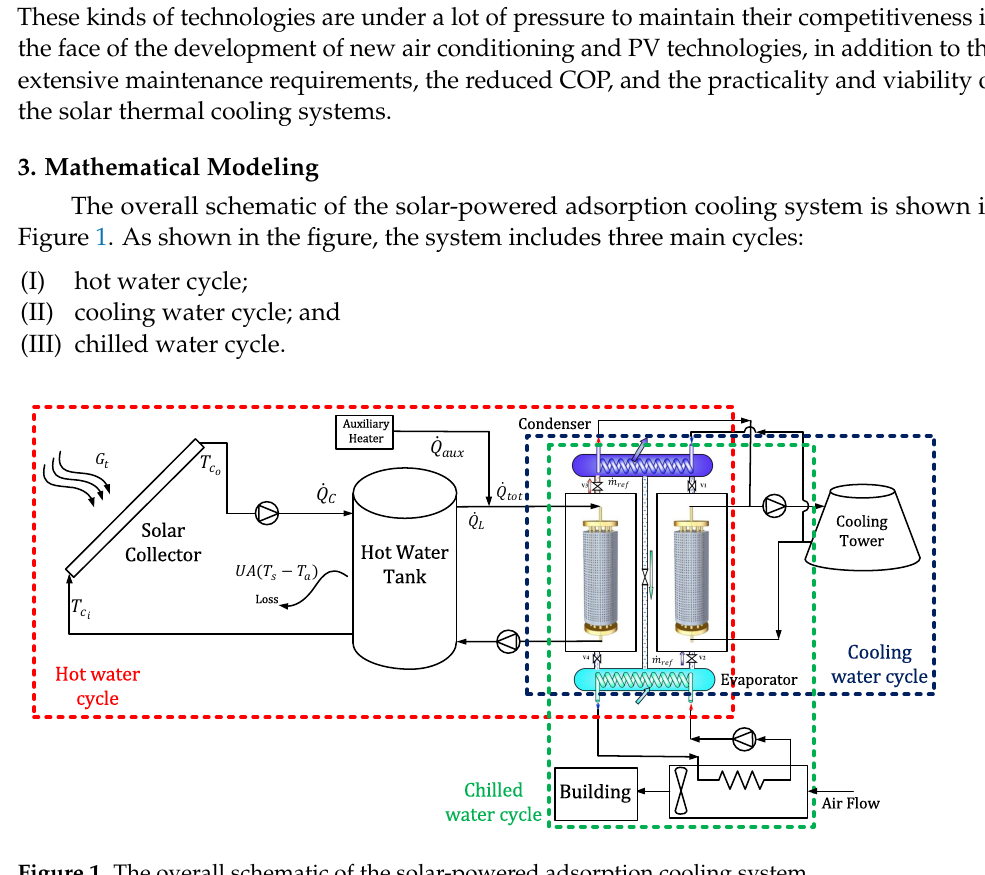
Figure 1. The overall schematic of the solar-powered adsorption cooling